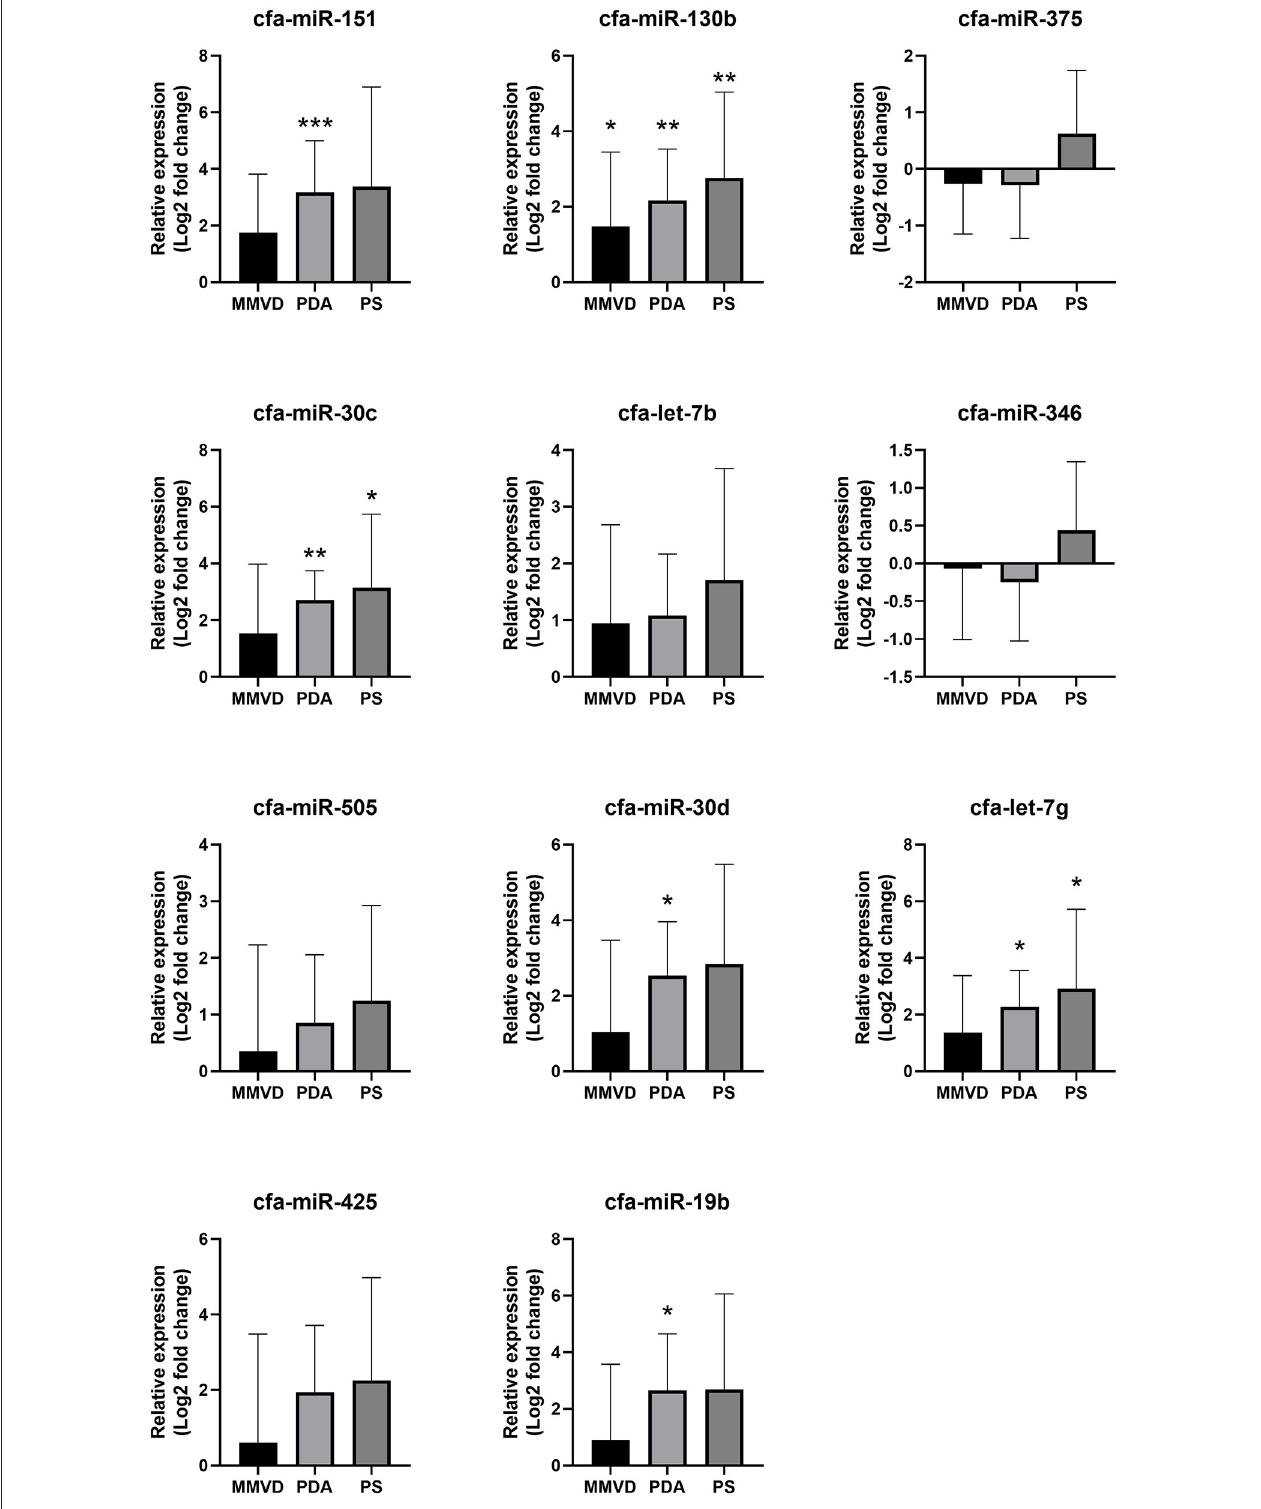
FIGURE 3 | Relative expressions of circulating miRNAs according to disease type. Data were presented as log2 transformed fold change relative to the healthy group (mean and standard deviation). MMVD, myxomatous mitral valve degeneration; PDA, patent ductus arteriosus; PS, pulmonic stenosis. * p < 0.05, ** p < 0.01, *** p < 0.001 in Kruskal–Wallis test, p -value adjusted by Dunn’s multiple comparison